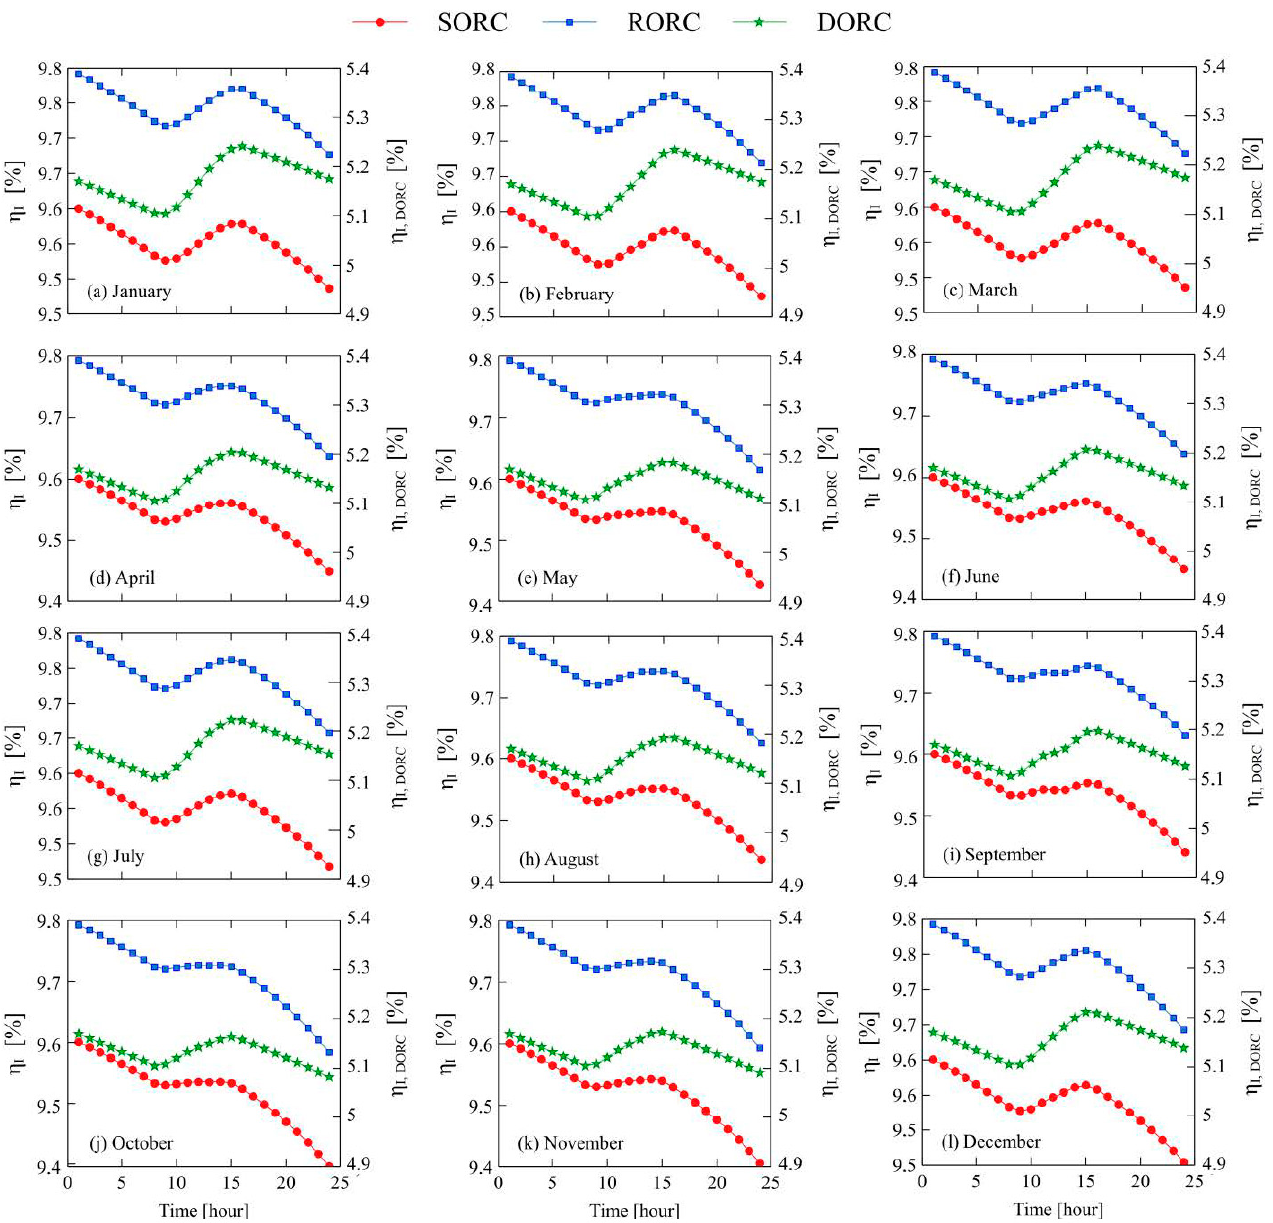
Figure 9. Daily variation of energy efficiency for the three configurations in Las Flores for each month from January to December.